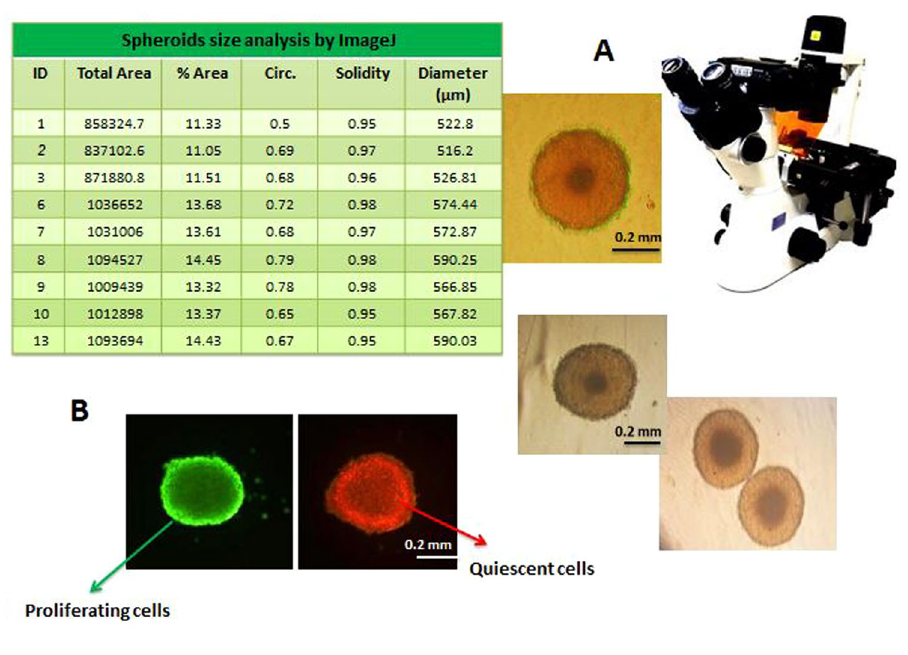
Figure 2. MDA-MB-231 cell spheroids. ( A ) MDA-MB-231 cell spheroid’s size and morphology inspected and imaged by bright field invert microscope. ( B ) AO and EB staining of a uniform spheroid, dark and orange highlighted regions (stained with EB) close to the center of the spheroid are mainly composed of quiescent/dead cells whereas, outermost layer which is highlighted in bright green (stained with AO) consists of proliferative, actively dividing